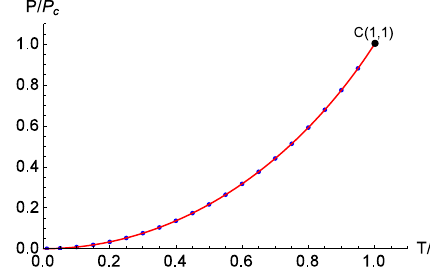
Fig. 2 Left The co-existence curve for the five-dimensional AdS hairy blackholewithoutcharges,the bluepoints forthenumericalvalues,and the red solid curve for the fitting formula. Right The co-existence curve